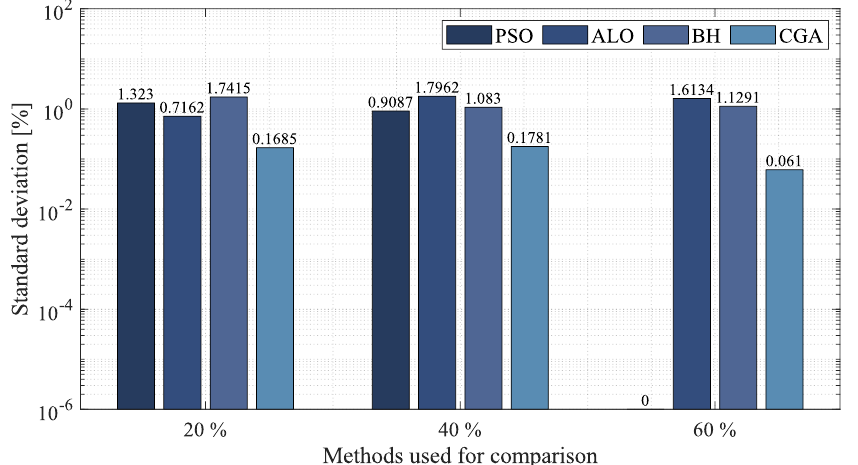
Figure 8. Percentage of standard deviation obtained by the MVO in the 10-node radial test system compared to other